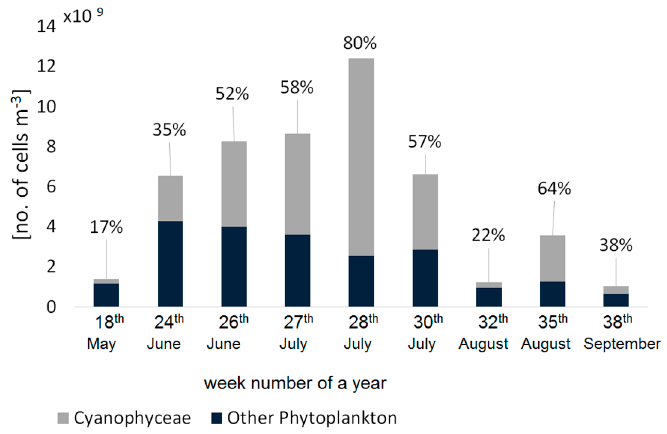
Figure 4. Ratio of cyanobacteria cell numbers per cubic meter compared to the cell number of all other phytoplankton species composition in the time series. Average values of the years 2012 – 2013.